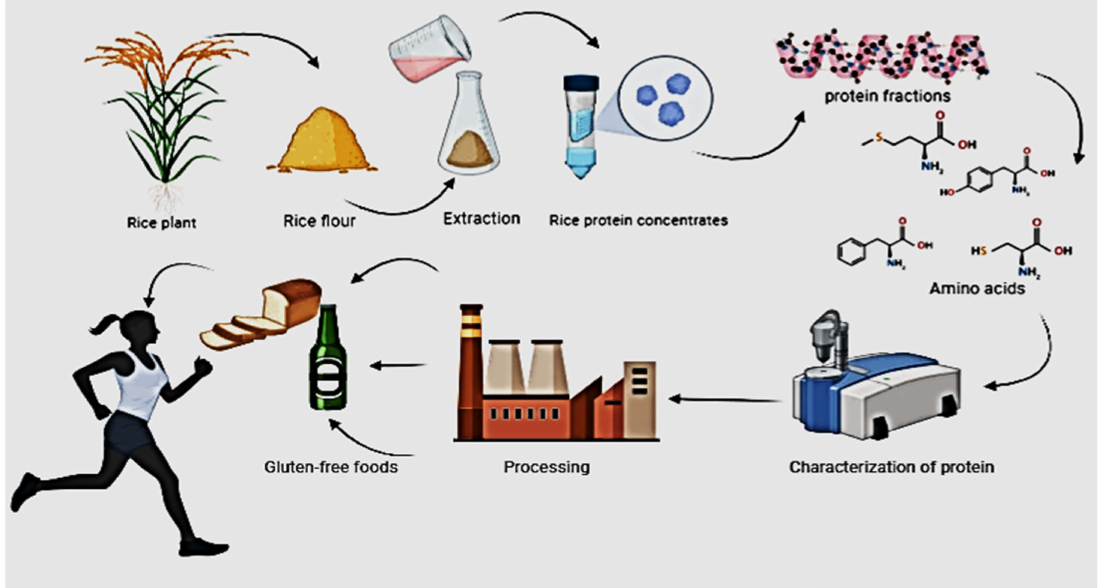
Figure 1. A simplified representation of the life cycle of rice protein from the rice plant to the human